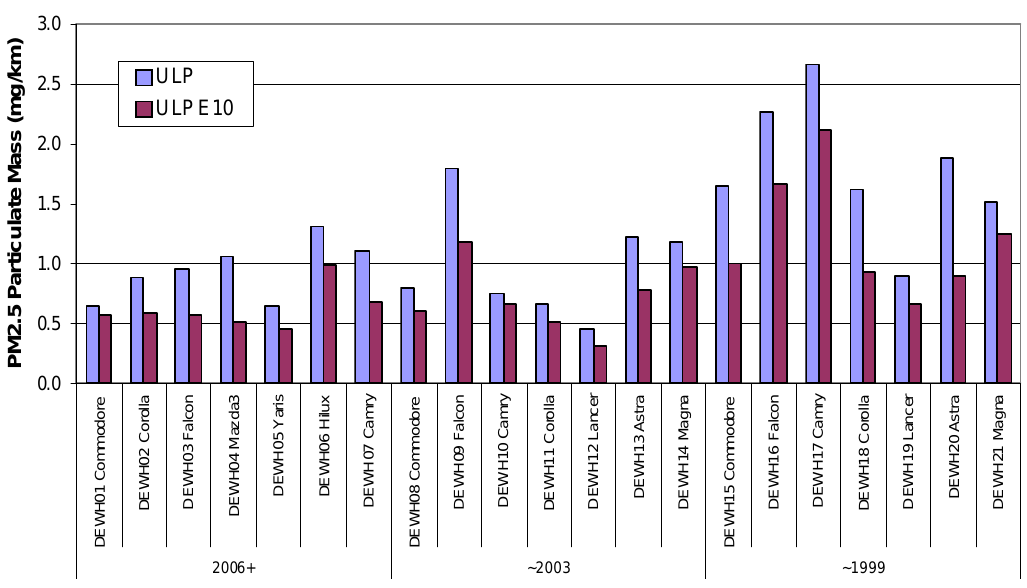
Figure 1. Comparison of emissions of PM for vehicles using ULP and E10 when tested 2.5 under the Composite Urban Emissions Drive Cycle (CUEDC). Fleet CUEDC PM: Overall Cycle ULP vs E10 (PM2.5, average of 5x repeats on each